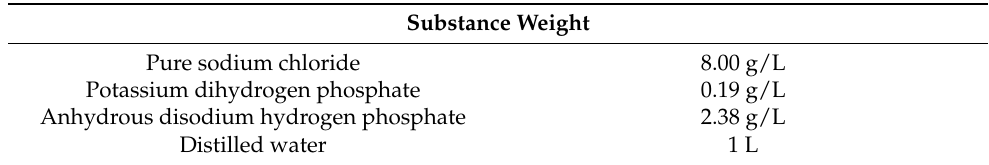
The flux (Jss) corresponds to the slope of the permeation profile’s linear section. The latency time (Tlag) was obtained from the extrapolation of the straight line resulting from the accumulated amounts as a function of time. The steady state plasma concentration (Css) was calculated assuming an area of application of 5 cm 2 according to the Equation (A1): where Css is the steady state plasma concentration (Css); J ( µ g/h) is the flux; TSA (cm 2 ) is the theoretical surface area of application; Cl p (mL/min) is the human plasma clearance of ketorolac, and A (cm 2 ) is the diffusion area of the Franz cells. The permeability coefficient was calculated in accordance with the Equation (A2): where Kp is the permeability coefficient of ketorolac through the membranes; J ( µ g/h) is Table A4 shows the composition of the artificial saliva. Table A4. Artificial saliva composition expressed in concentration (g/L).